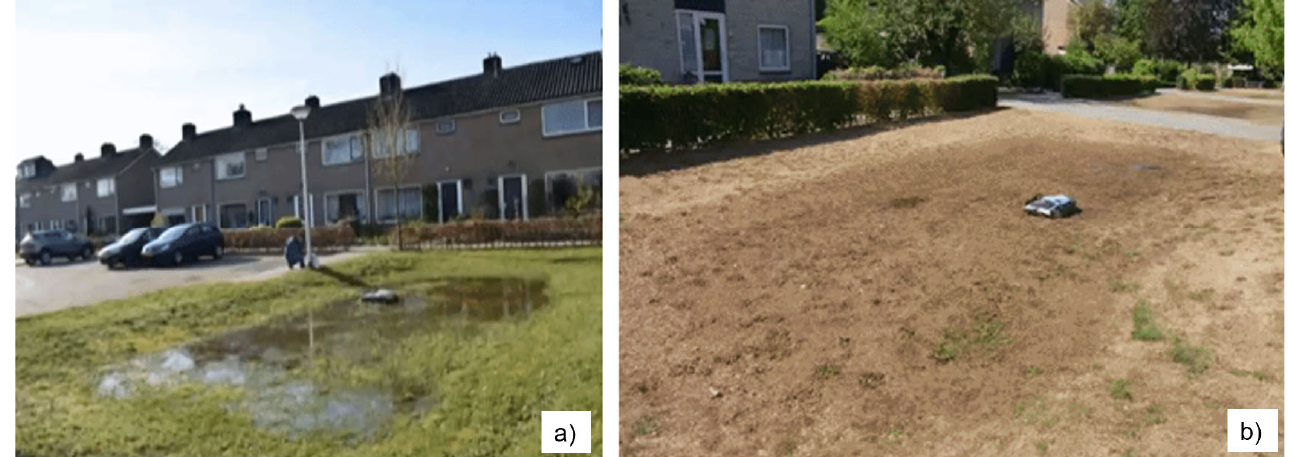
Figure 1. ( a ) Swale at study site in the municipality Dalfsen showing normal condition in 2017 and ( b ) the same swale after a 7 ‐ weeks dry period in 2018. The swales in Dalfsen is the case study presented in this paper.